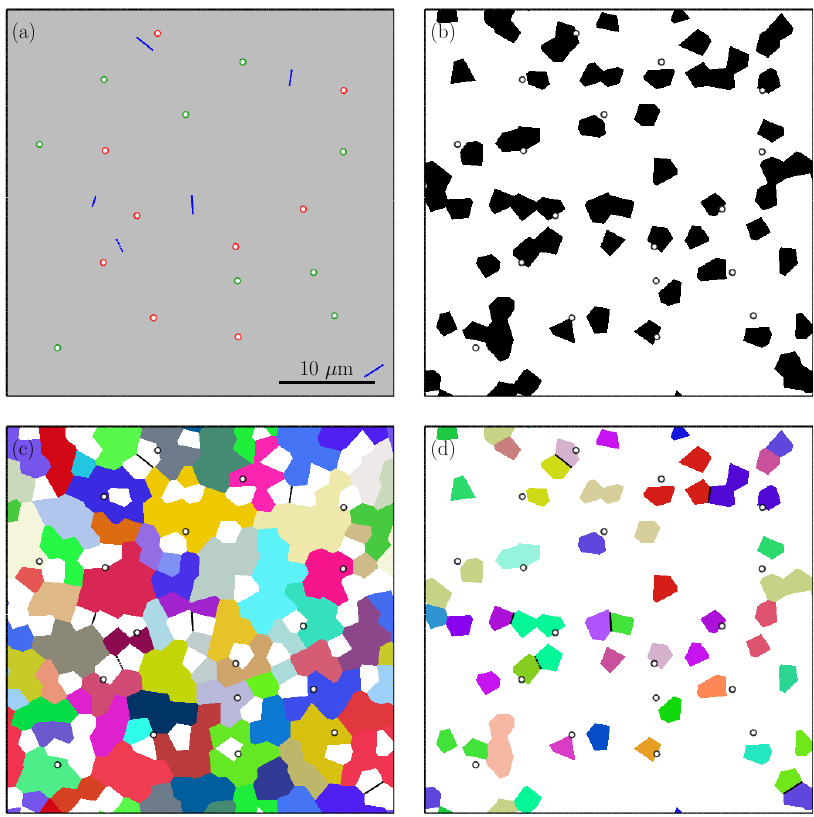
Figure 3. RVE with random morphology, ( a ) voids (green: voids in ferrite, red: voids at the ferrite–martensite boundary) and cracks (blue), ( b ) ferrite (white) and martensite (black), ( c ) colors indicate 67 ferrite orientations, ( d ) colors indicate 32 martensite orientations.